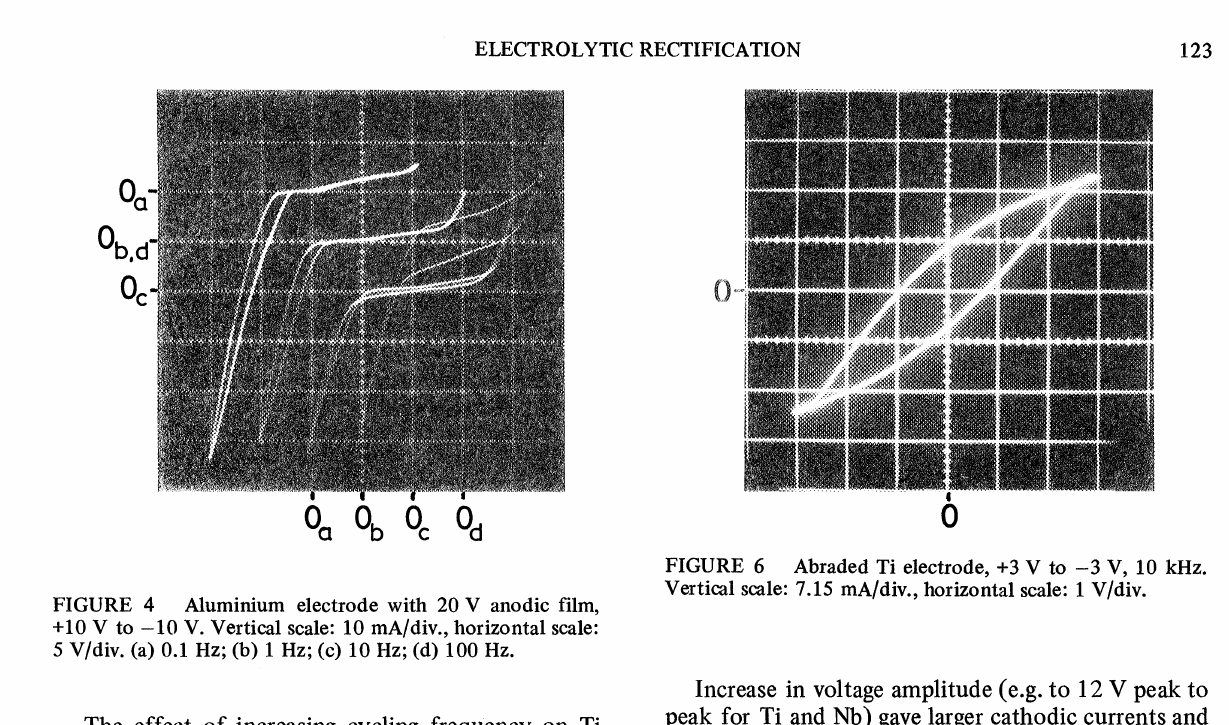
FIGURE 4 Aluminium electrode with 20 V anodic film, +10 V to -10 V. Vertical scale: 10 mA/div., horizontal scale: 5 V/div. (a) 0.1 Hz; (b) Hz; (c) 10 Hz; (d) 100 Hz.